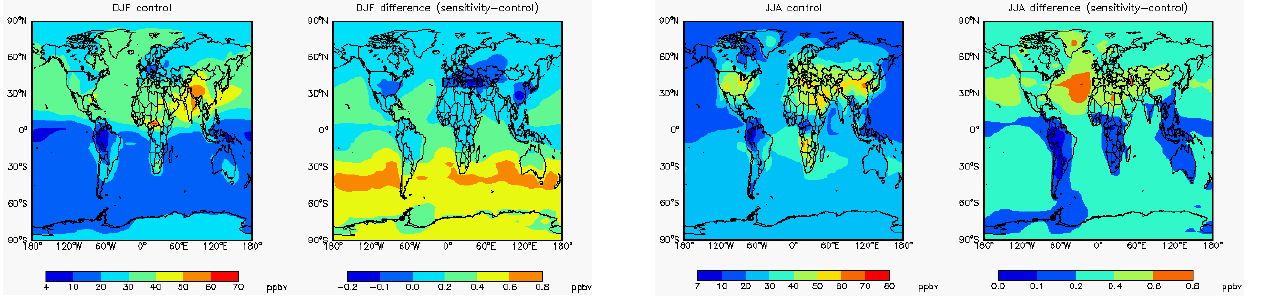
Fig. 3b. Same as Fig. 3a, but for